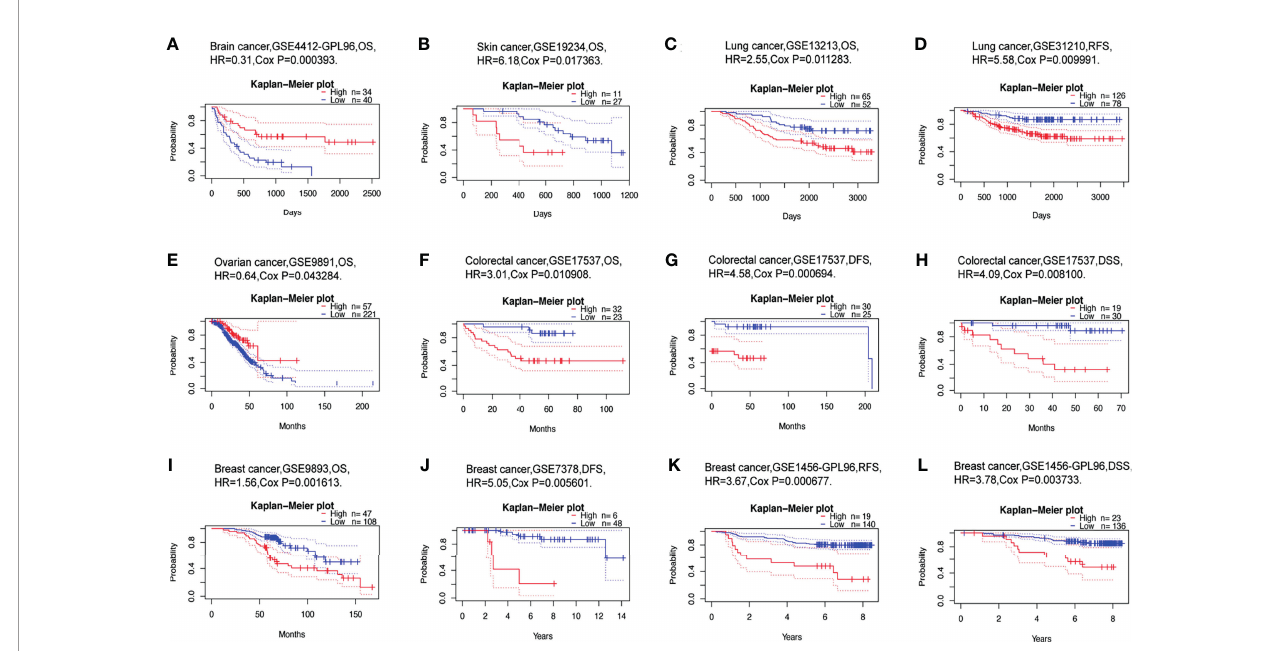
FIGURE 4 | Correlation between USP10 expression and the prognosis of various types of cancer using data from the PrognoScan database. (A) Overall survival (OS) of a cohort of 74 patients with brain cancer (GSE4412-GPL96). (B) OS of a cohort of 38 patients with skin cancer (GSE19234). (C, D) OS and relapse-free survival (RFS) survival curves for patients in two lung cancer cohorts [GSE13213 (n=117) and GSE31210 (n=204)]. (E) OS of a cohort of 278 patients with ovarian cancer (GSE9891). (F – H) OS (n = 55), disease-free survival (DFS) (n = 55), disease free survival (DSS) (n = 49) survival curves for a cohort of patients with colorectal cancer (GSE17537). (I, J) OS and DFS survival curves for two cohorts of patients with breast cancer [GSE9893 (n =155) and GSE7378 (n =54)]. (K, L) RFS (n =159) and DSS (n =159) survival curves for a cohort of patients with breast cancer (GSE1456-GPL96). Patients with high USP10 expression are represented by the red curve. Signi fi cance is indicated by a P -value <